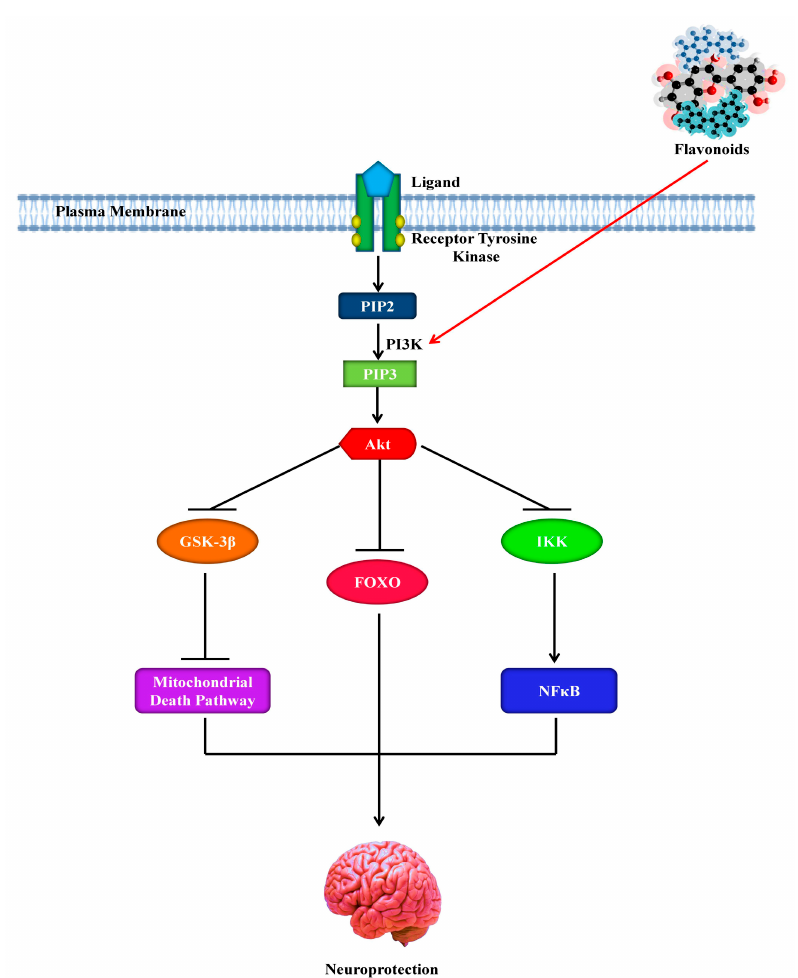
Figure 5. Neuroprotective effect of flavonoids by activating the phosphoinositide 3-kinase pathway. PI3K, phosphoinositide 3-kinase; GSK-3 β , glycogen synthase kinase 3 β ; Akt, protein kinase B; PIP2, phosphatidylinositol-3,4-biphosphate; PIP3, phosphatidylinositol-3,4,5-triphosphate; FOXO, forkhead box; NF κ B, nuclear factor κ B; IKK, I κ B kinase.